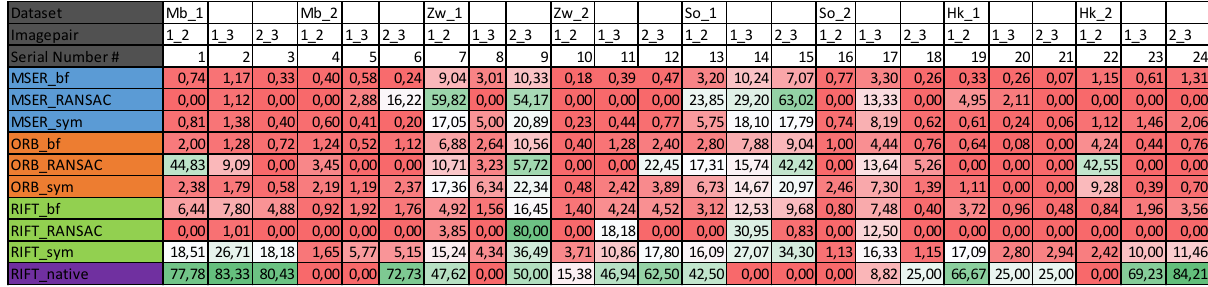
Table 1. Results for different feature matching methods for 8 different image triples (=24 image pairs). Matching results are shown respectively for every dataset for the image pairs 1_2, 1_3 and 2_3 as ration in % between all found matches and correct matches (matching score). Good results are highlighted in green whereas bad results are shown in red